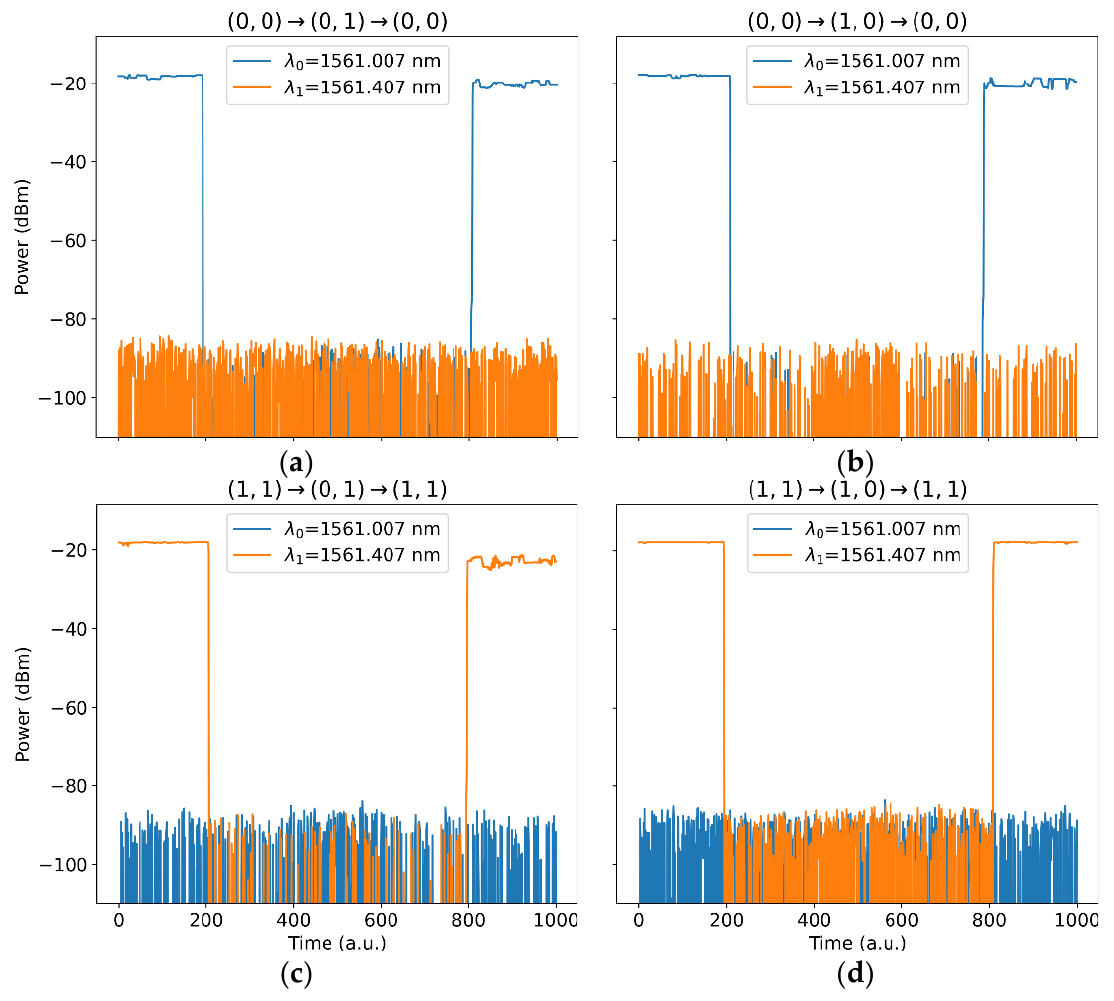
and for the transitions: ( a ) (1,1) and ( d ) (0,0) (0,1) (0,0). 𝜆𝜆 0 𝜆𝜆 1 → → →